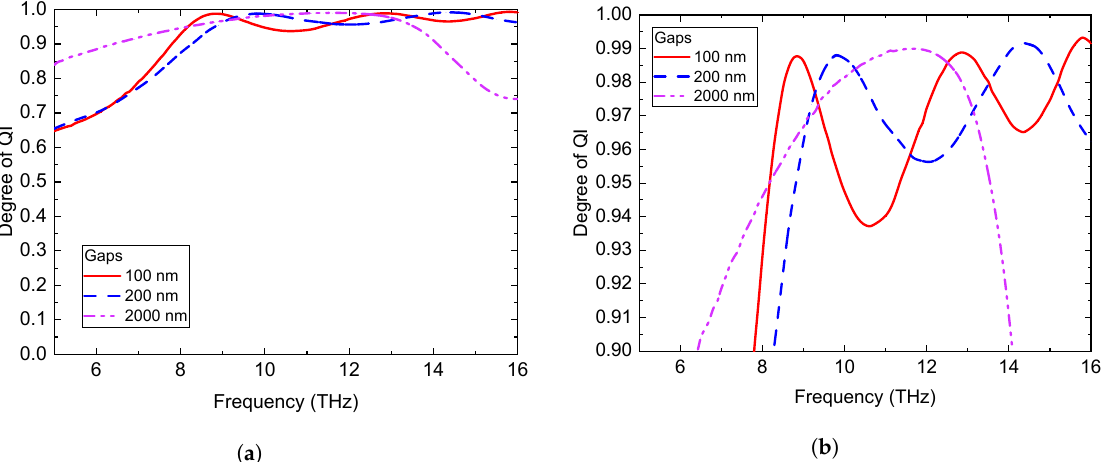
Figure 3. ( a ) The degree of QI ( p ) in a dimer of Bi 2 Te 3 microspheres with 2 µ m radius, as a function of frequency for different gaps. In order to study in more detail the behavior of these curves for high values of p , in ( b ) we have zoomed the upper part of ( a ) with the values of p lying in the range [ 0.9,1.0 ]